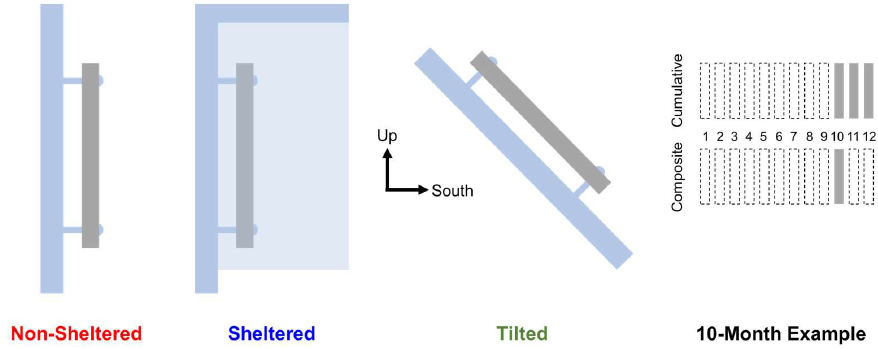
Figure 2. Examples of the different exposure conditions (Thin geometry shown). Samples were exposed both cumulatively and monthly. Cumulative samples ( C ) were pulled each month which had been exposed from the beginning of the deployment until the time of retrieval. Monthly samples ( M ) were pulled each month which had only